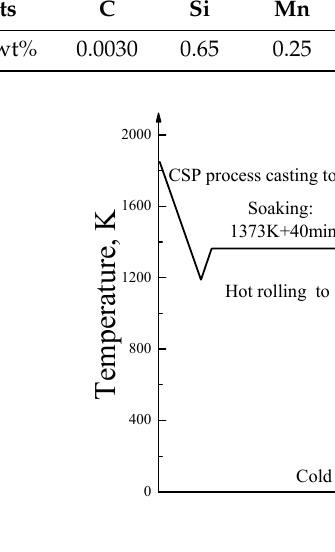
Figure 1. Schematic of the thermos-mechanical cycle used in the present study.